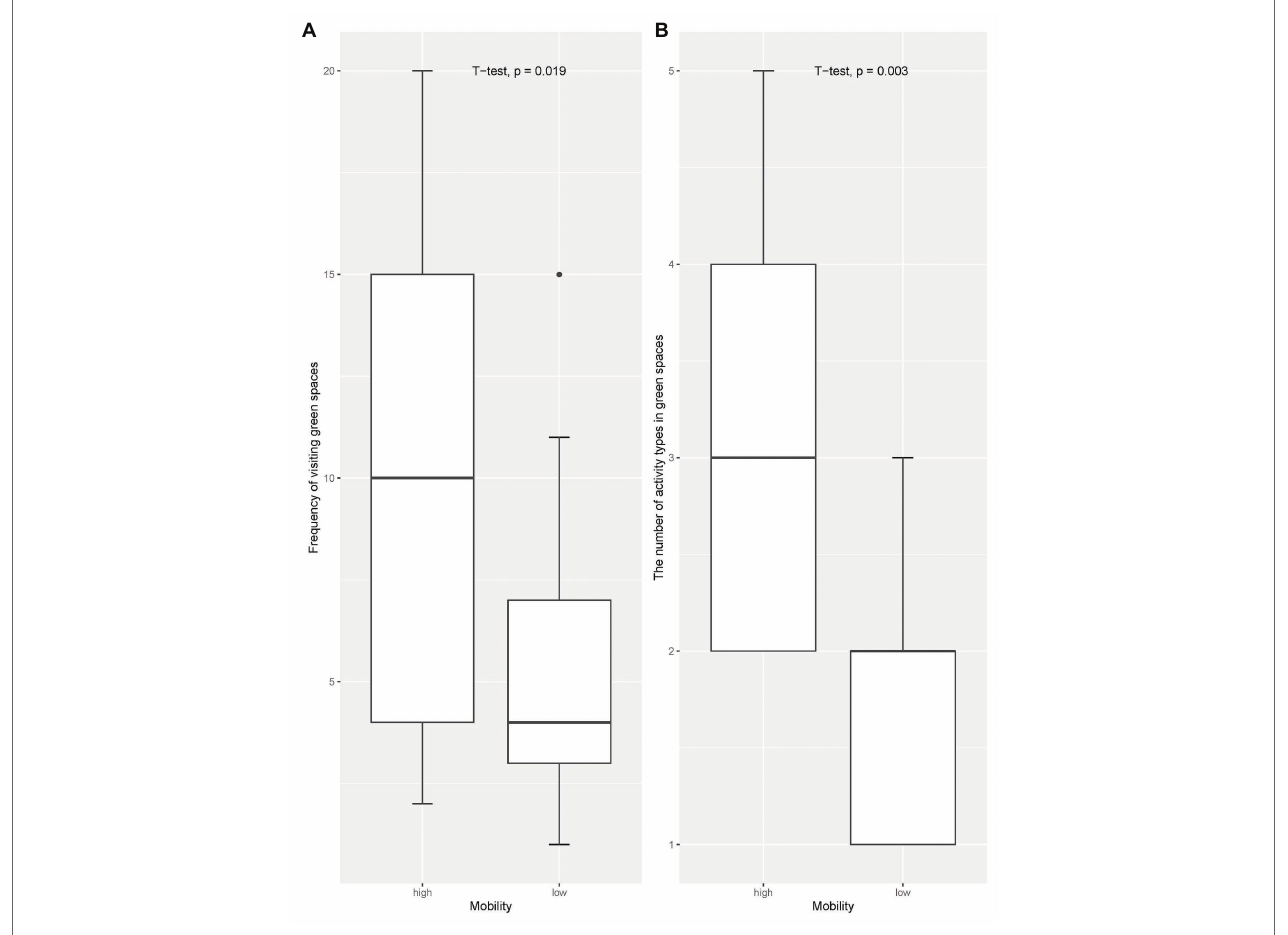
FIGURE 4 | Box plot illustrating the frequency of visits to green spaces and the types of activities undertaken with reference to the participants mobility level. (A) Comparing frequency of visiting green spaces between high and low mobile groups. (B) Comparing the number of activities undertaken in public green spaces by high- and low-mobility